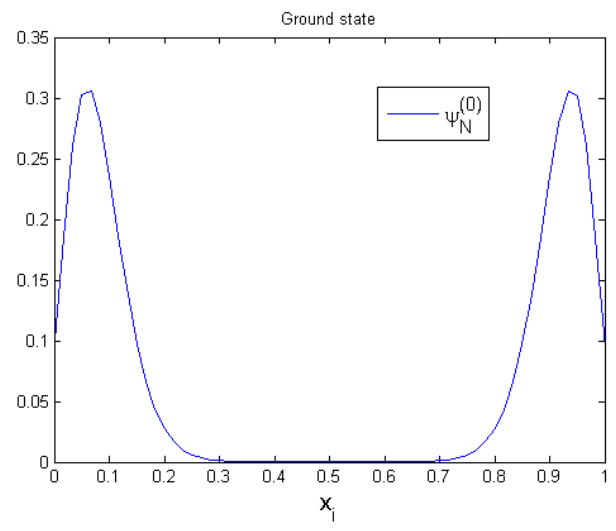
Figure 1: Ground state eigenfunction of h CW J for N = 60 , J = 1 and B = 1 / 2 . The grid points on the horizontal axis are labeled N + 1 = i / N for i = 0,..., N. by x i